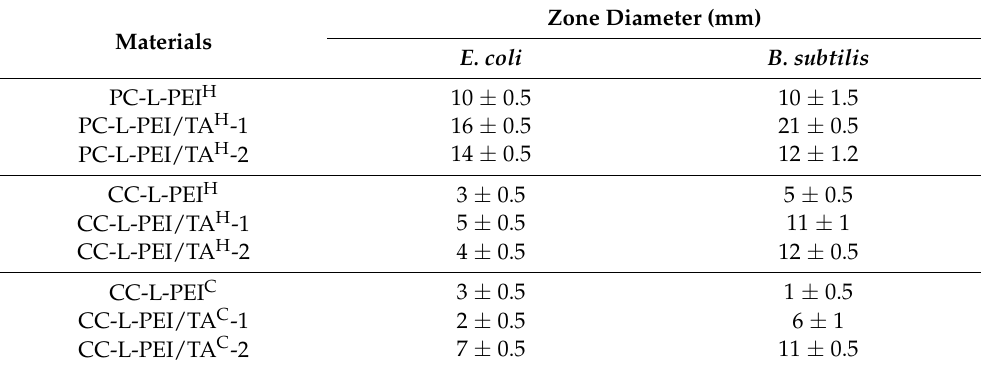
Table 4. Inhibition zone diameters (mm) of L-PEI-based materials against E. coli and B. subtilis strains.